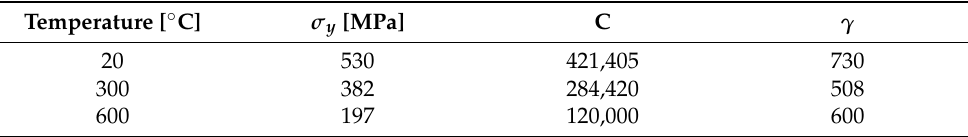
Table 4. Flow Stress model—Armstrong-Frederick kinematic hardening law parameters for the 15-5PH